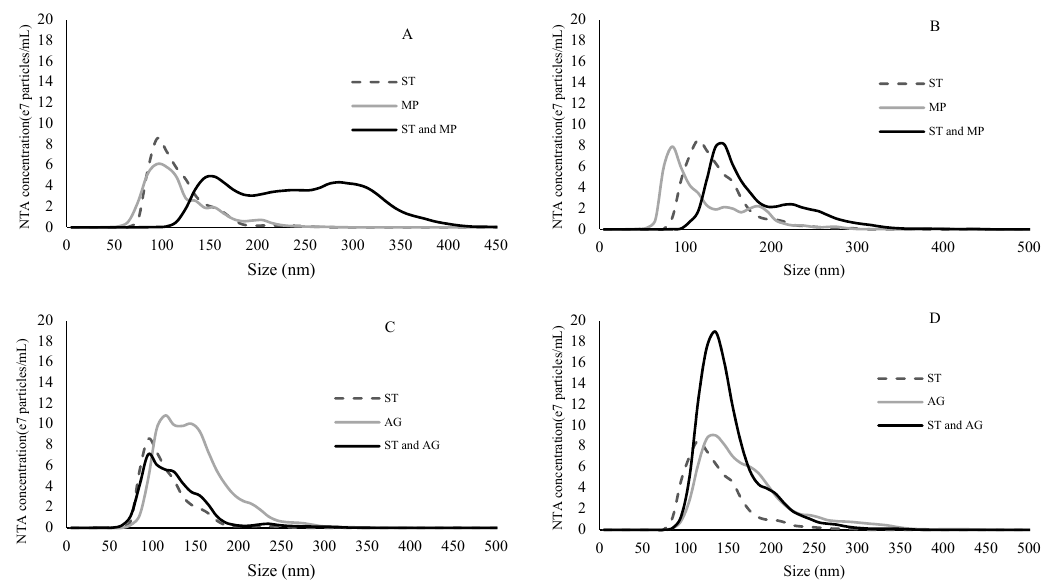
Figure 4. Size distribution of binding experiments between 5 mg / mL tannin and 0.5 mg / mL polysaccharides determined by nanoparticle tracking analysis. The curves are from an average of 15 measurements. ( A ) ST and MP in 12% ethanol model wine; ( B ) ST and MP in 15% ethanol model wine; ( C ) ST and AG in 12% ethanol model wine; and ( D ) ST and AG in 15% ethanol model wine. All ST-containing solutions were diluted 1:40 with model wine prior to analysis.